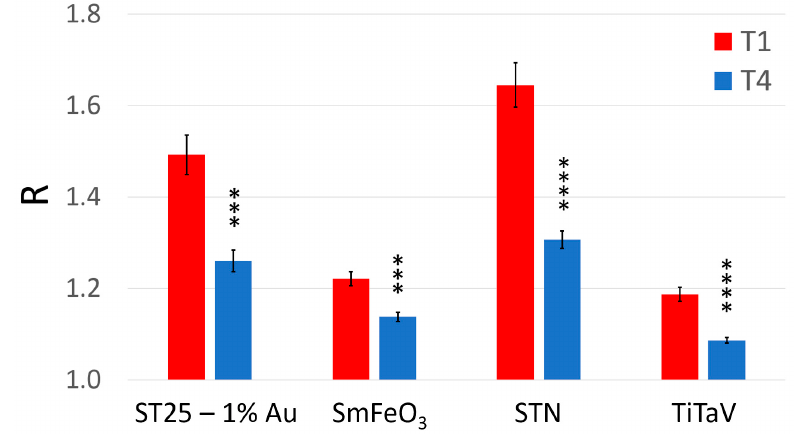
Figure 5. Average sensor responses (R) to the blood collected just before surgery and after about one year of follow-up. Response R averaged on all patients and relative standard error (reported numerically in Table 1) of each sensor at the two blood collection times (red, T1; blue, T4). The statistically significant differences between T1 and T4, for each sensor, have been calculated with a significance level α = 0.01 (*** p < 0.001; **** p < 0.0001). This difference is further highlighted by the significant statistical separation between the T1 and T4 populations by the confidence interval analysis performed by using the Student’s t distribution ( n = 30 for T1 and n = 28 for T4) with a 95% confidence interval (significance level: α = 0.05; Figure 6).